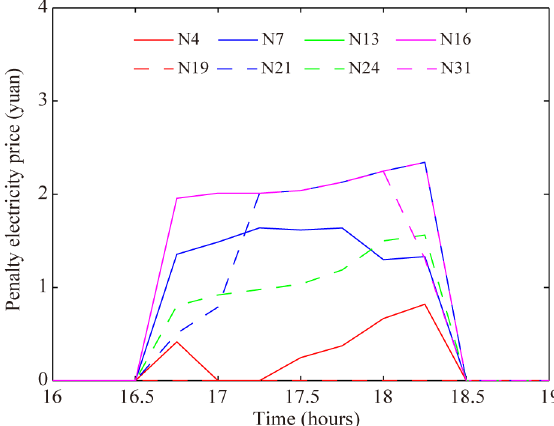
Figure 17. Penalty electricity price under random fluctuation.